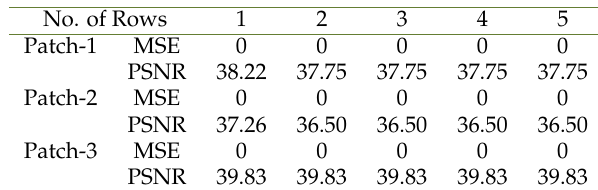
Table 1. PSNRs / MSEs calculations from the details of five rows of damaged